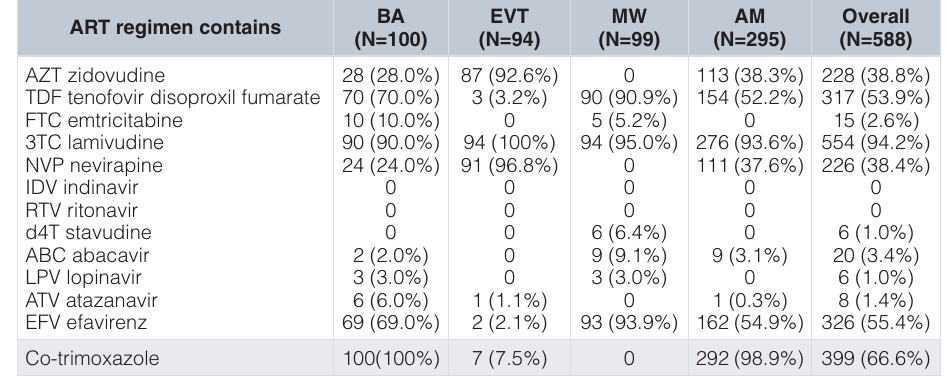
Table 3. Antiretroviral therapy (ART)